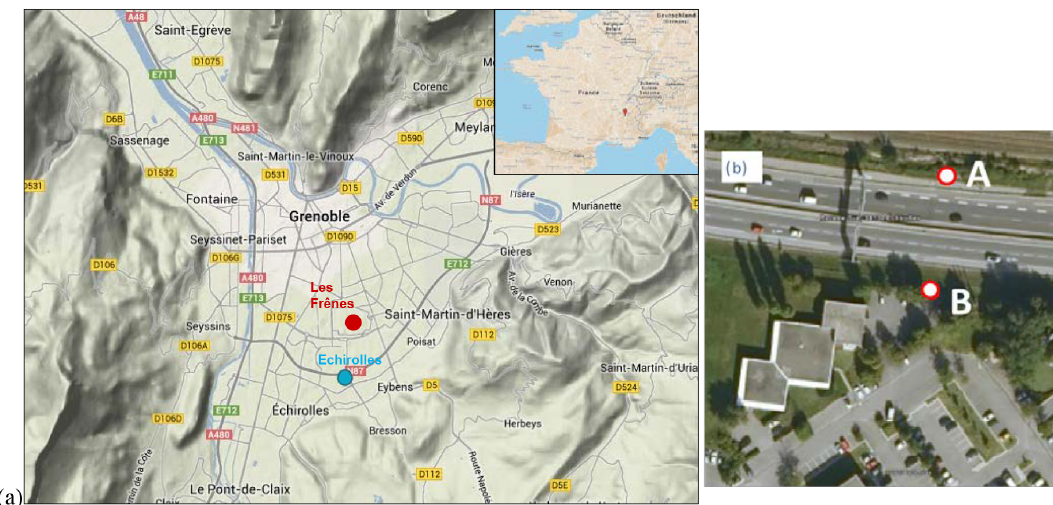
Figure 1. (a) Location of sampling sites in the Grenoble Alpes conurbation: the roadside site (Echirolles) and the urban background site (Les Frênes). (b) Echirolles sampling site: sampling and measurement devices are around the B point; the traffic electromagnetic loop monitoring is beneath the road (on the AB line), on the left; and the cameras linked to automatic license plate recognition code are located on overhead